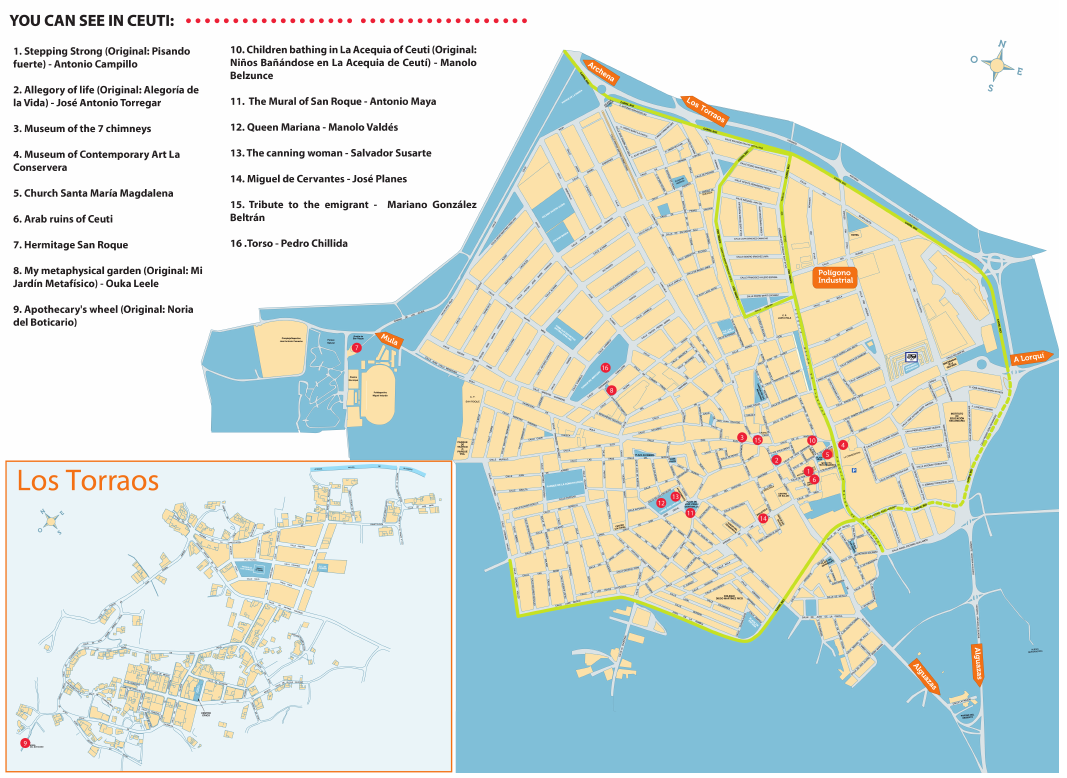
Figure A1. Smart POIs’ geolocation (based on Map—“7 Chimneys” Museum [34]).